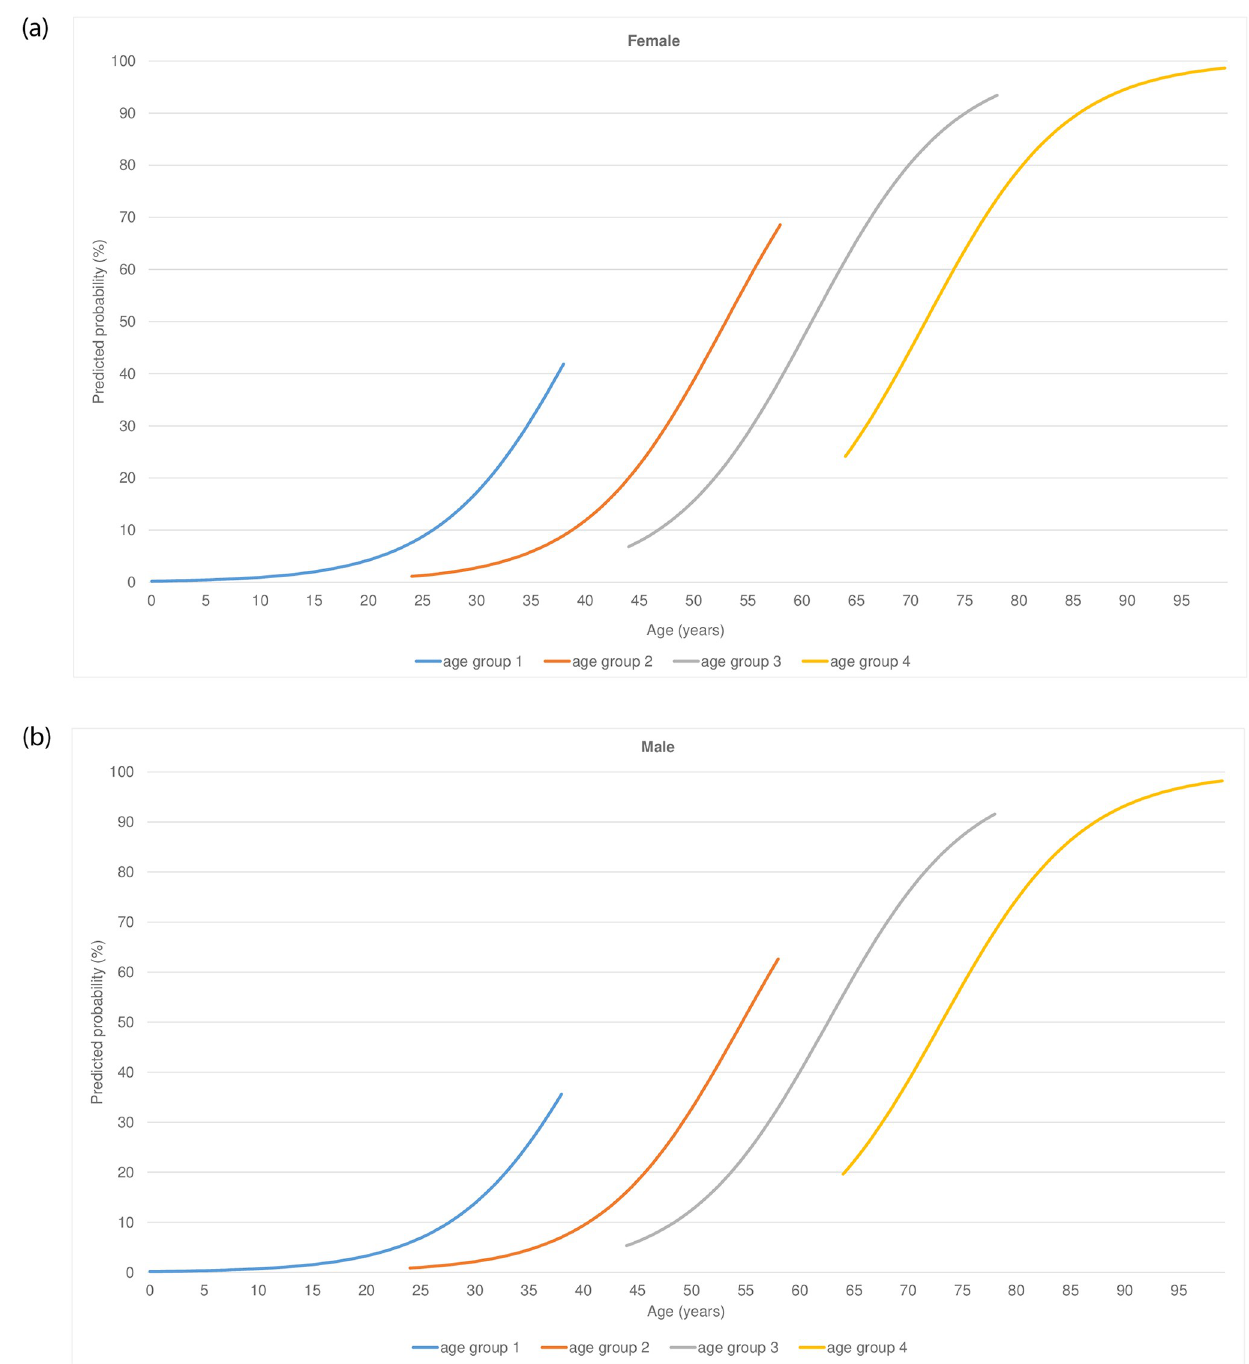
Fig 2. Age and age group effects on multimorbidity over time stratified by sex—Females (a) and males (b) (Y-axis: Predicted probability (proportion) of multimorbidity stratified for sex and age-groups (1 = 0–24 year; 2 = 25–44 year; 3 = 45–64 year; 4 = 65 year and older) during 15-year trajectory; X-axis: Age as time-varying variable, including a squared age-term).